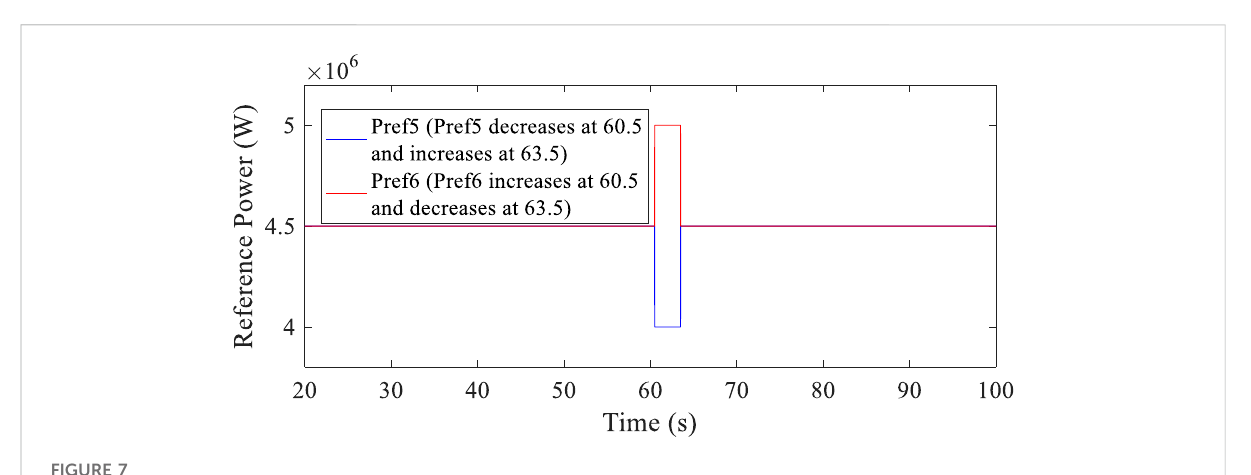
FIGURE 7 Two different reference power values used for testing under Wind1